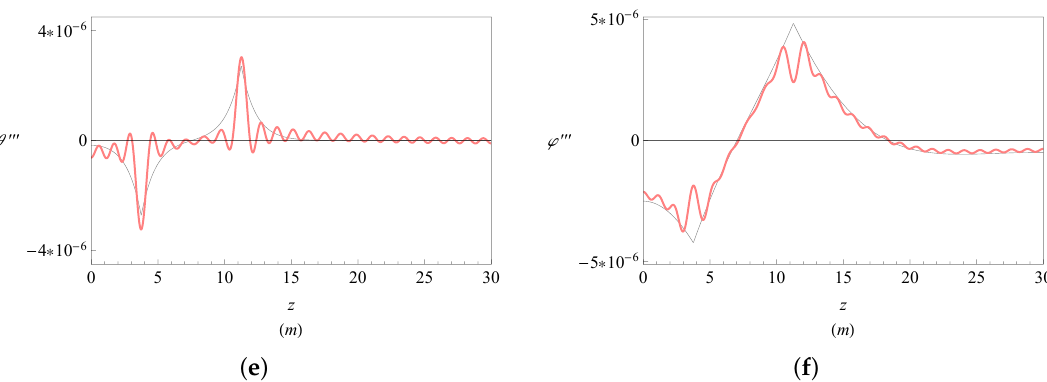
Figure 15. Derivatives of deflections: ( a , c , e ) twist angle derivatives, ( b , d , f ) distortion derivatives; comparison between Fourier ( N = 50 terms, thick red lines) and uncoupled solutions to the differential equations (thin gray